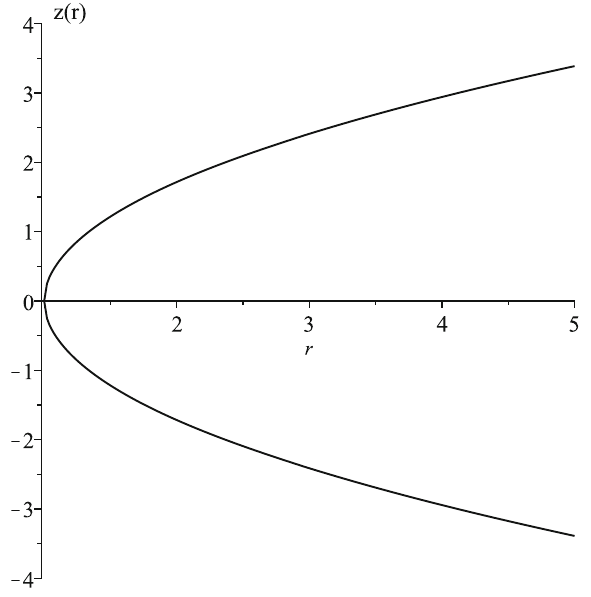
Fig. 1 Representation of the embedding